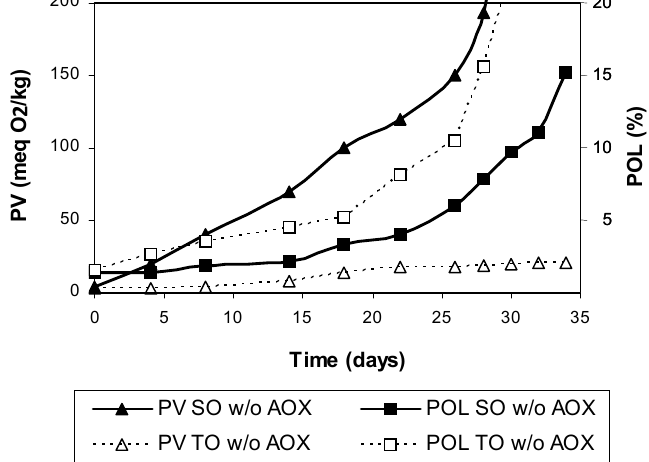
Figure 3. Peroxide values and polymer concentrations during storage of antioxidant-stripped safflower oil (SO w/o AOX) and Tonalin oil (TO w/o AOX) at 25 °C in the dark. Data are expressed as Means ( n = 3 experiments). Coefficients of variation were equal to or